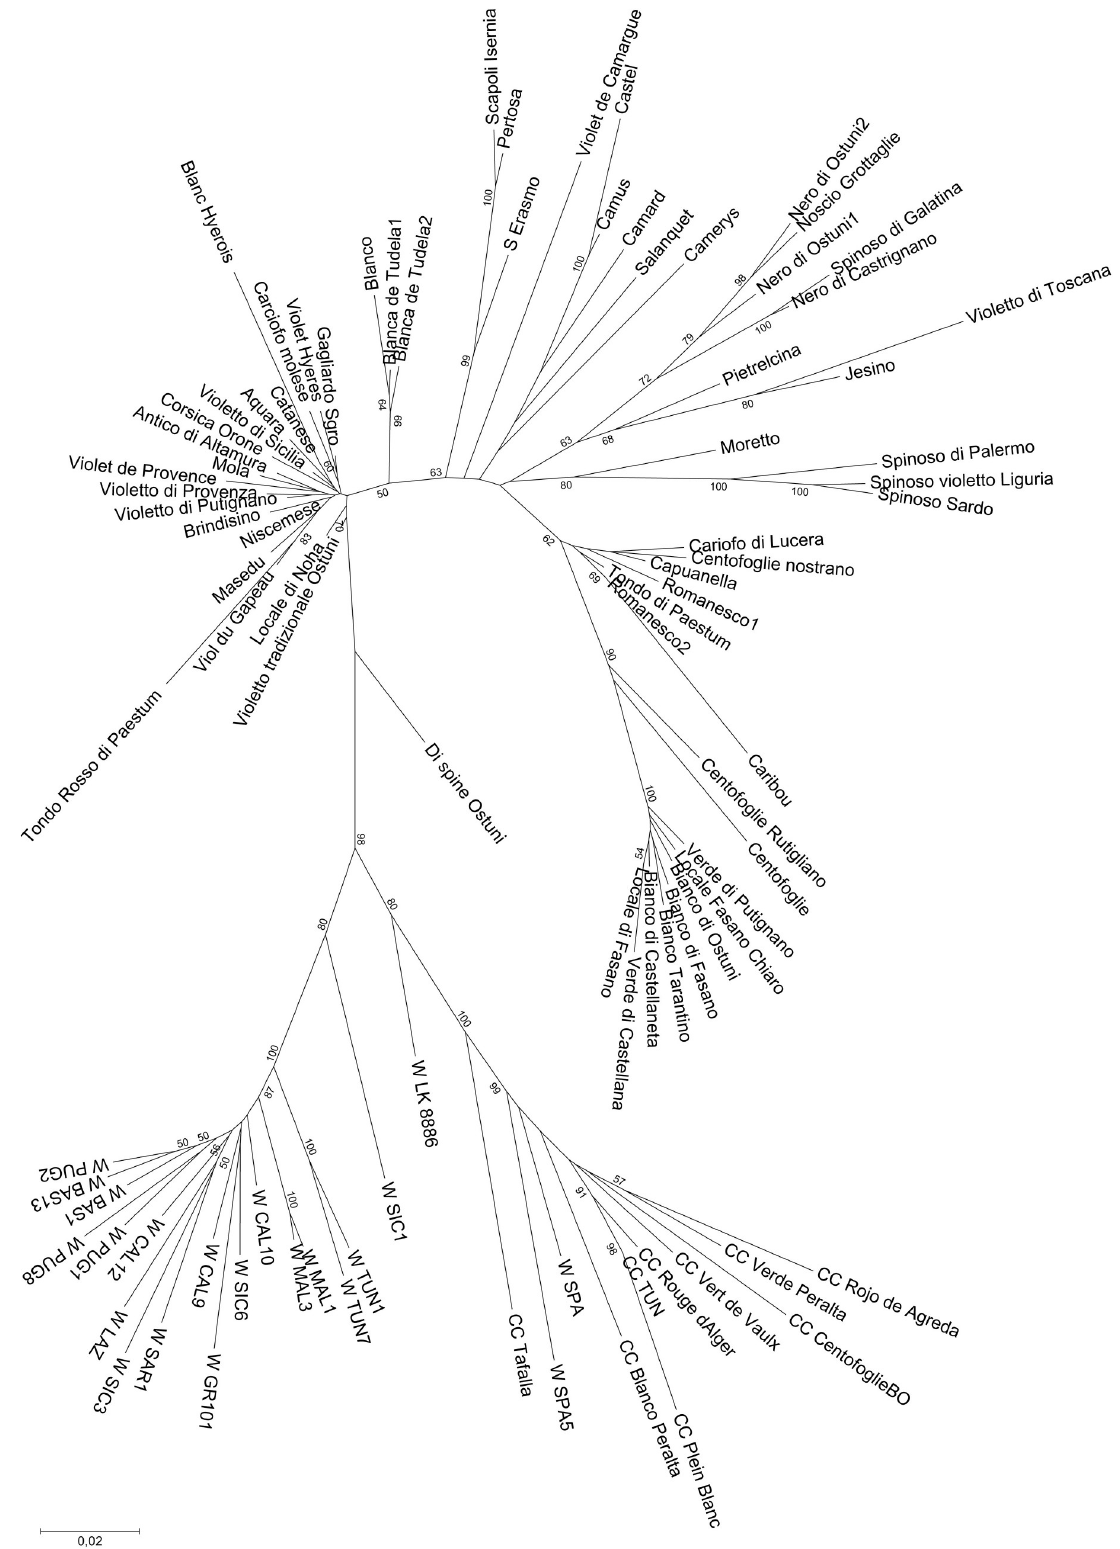
Fig 5. Neighbor-Joining tree obtained from SNP data on the whole dataset of Cynara cardunculus genotypes Number on tree branches indicate bootstrap values ( � 50). https://doi.org/10.1371/journal.pone.0205988.g005 PLOS ONE | https://doi.org/10.1371/journal.pone.0205988 October 23,